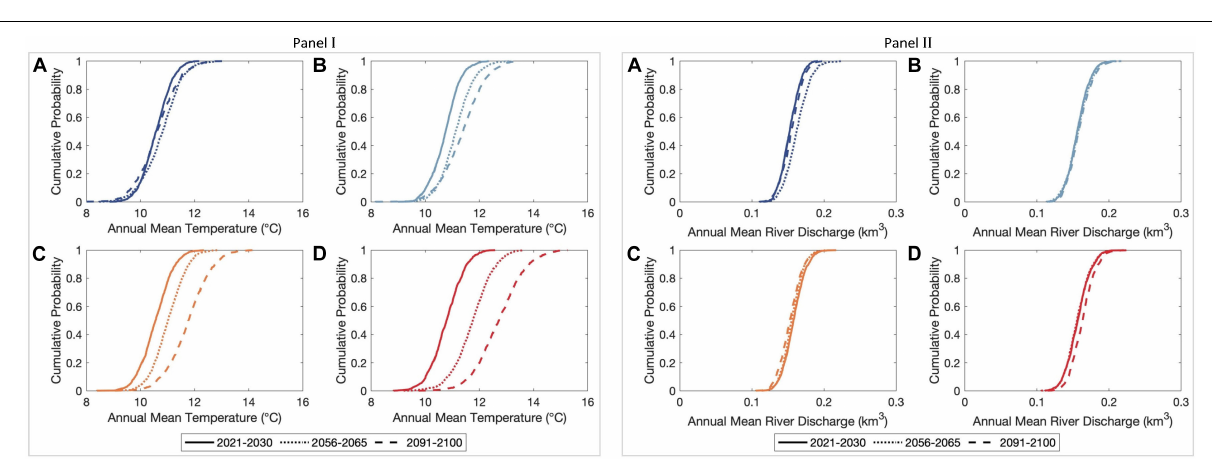
FIGURE 3 | Empirical cumulative distributions of averaged annual mean temperature (Panel I) and the annual cumulative river discharge (Panel II) in the Dyfi River catchment, Wales, the United Kingdom over the three decadal periods considered. Subplots (A) , (B) , (C) , and (D) are for the RCPs 2.6, 4.5, 6.0, and 8.5,